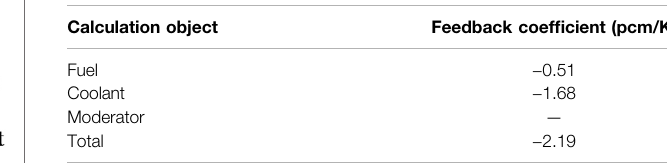
TABLE 2 | Temperature feedback coef fi cient of standard